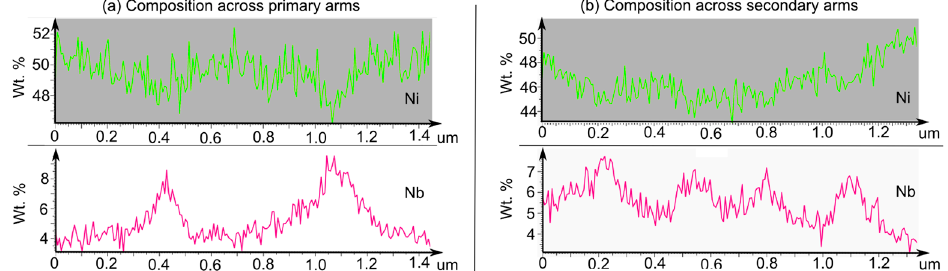
Figure 3. EDS map representing Ni and Nb segregation across ( a ) primary dendrite arm and ( b ) secondary dendrite arm. An overlay of representative dendrite arms (orange) has been placed on the backscatter electron image of the line scan to aid with visualization.